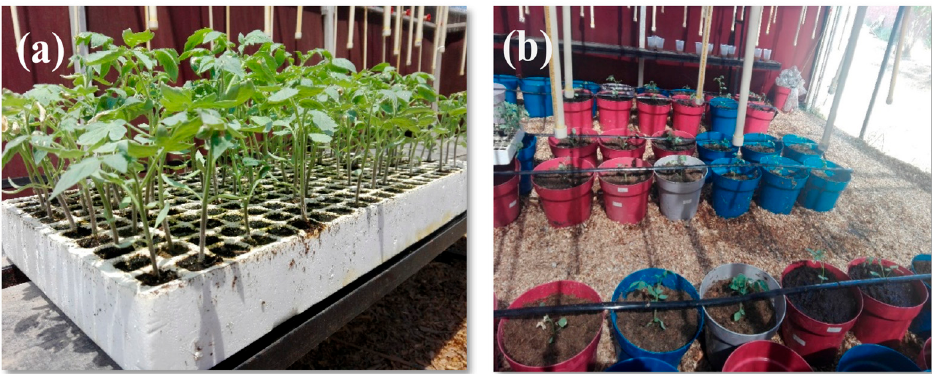
Figure 1. Photographs summarizing ( a ) the seedlings growth and ( b ) transplantation using plastic pots.